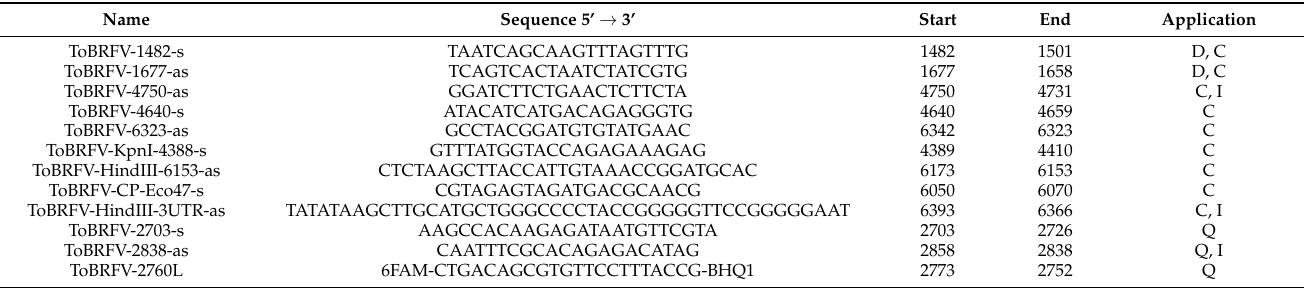
Table 3. Characteristics of oligonucleotides used in this study. The position of the nucleotides is shown based on ToBRFV isolate Tom1-Jo